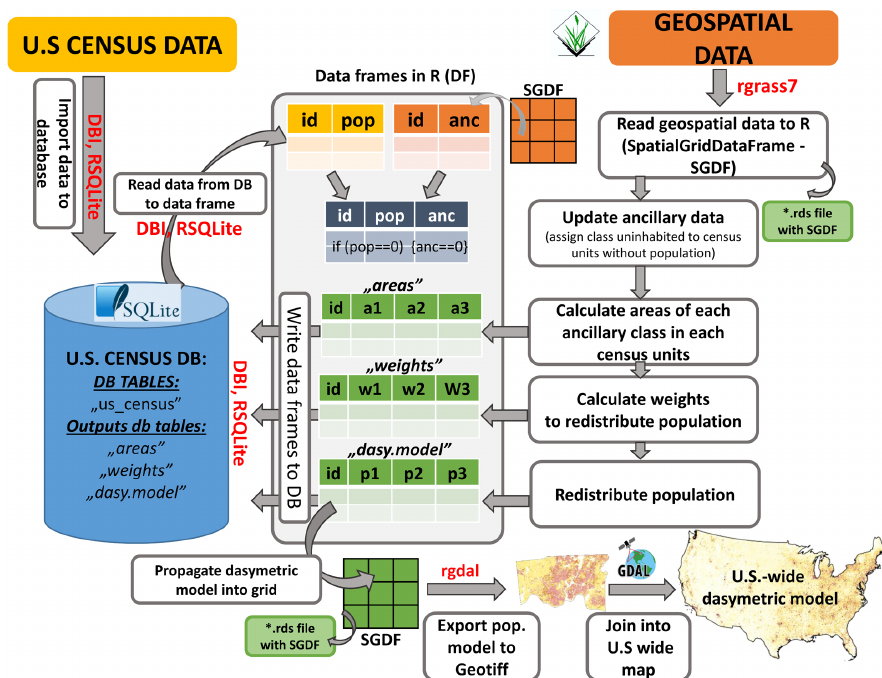
Fig. 2. Framework of calculation dasymetric modelling in